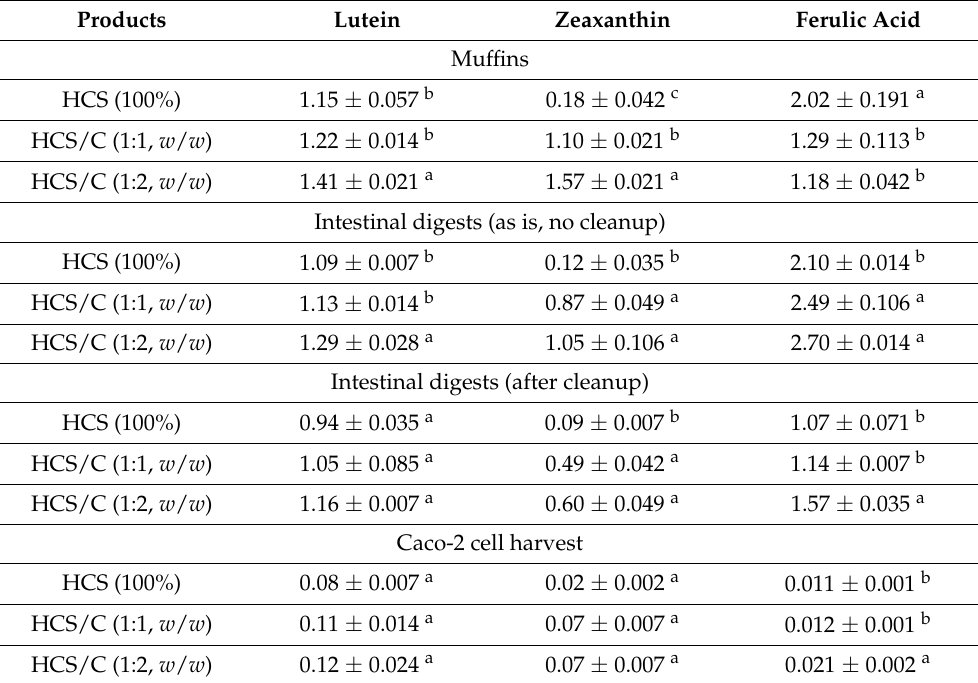
Table 2. Actual concentration of lutein, zeaxanthin, and ferulic acid in muffins, their digesta without and with cleanup, and Caco-2 cell harvest ( µ g/g, as is basis, Mean ± SD) x . Products Lutein Zeaxanthin Ferulic Acid Muffins HCS (100%) 1.15 ± 0.057